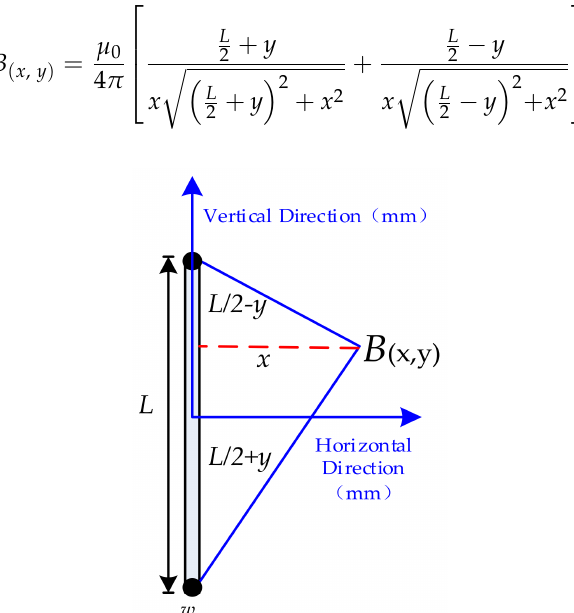
Figure 6. Equivalent diagram of the coil and